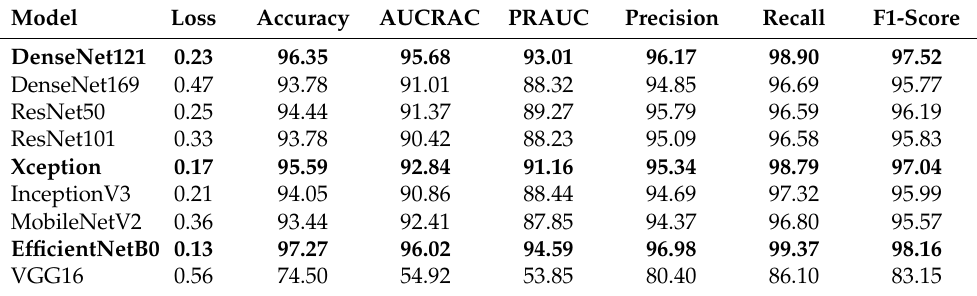
Table 3. The performance analysis of various models for gender classification on test dataset when trained on images with veiled faces (faces with masks in three different ways/styles of wearing).